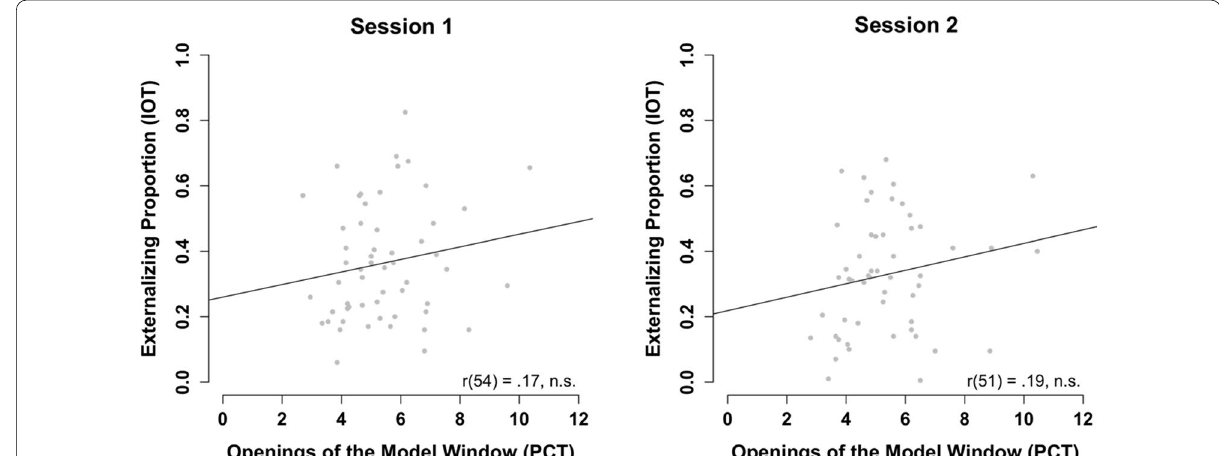
Fig. 4 Depictions of the insignificant correlations between the cognitive offloading measures of the intention offloading task (IOT) and the pattern copy task